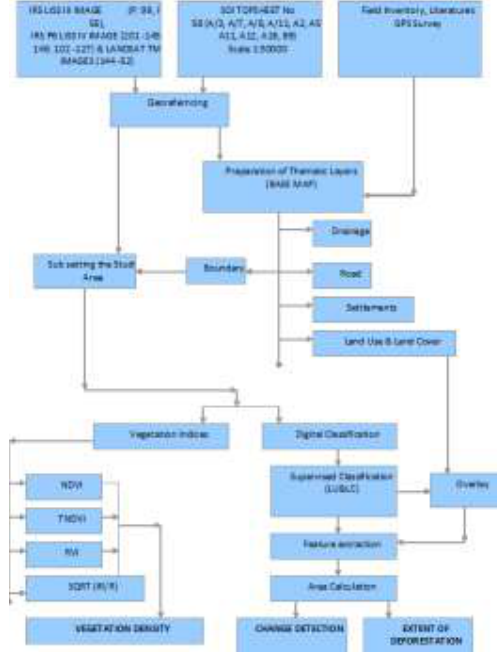
Figure-6- Methodological